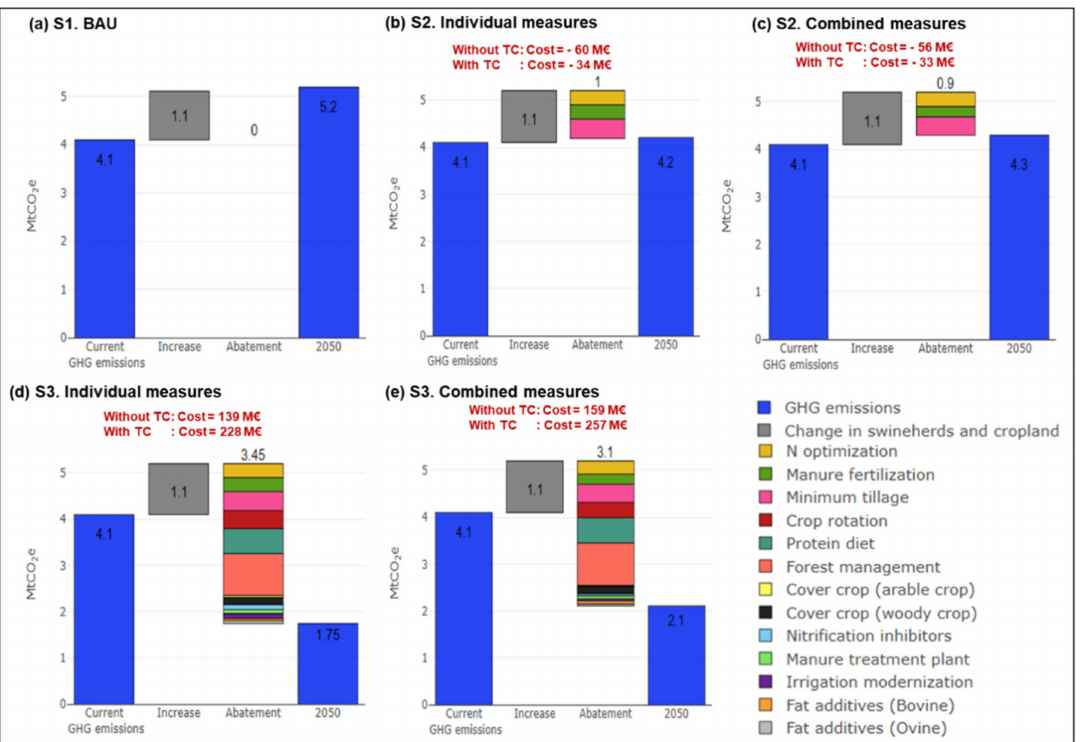
Figure 5. Mitigation policy scenarios for the 2050 horizon. The figure shows the current and the 2050 emissions under the different scenarios. “Increase” refers to the increase of emissions in 2050 from changes in swineherds and cropland, and “Abatement” refers to the reduction of emissions from measures. BAU is the Business as Usual scenario, and TC are transaction